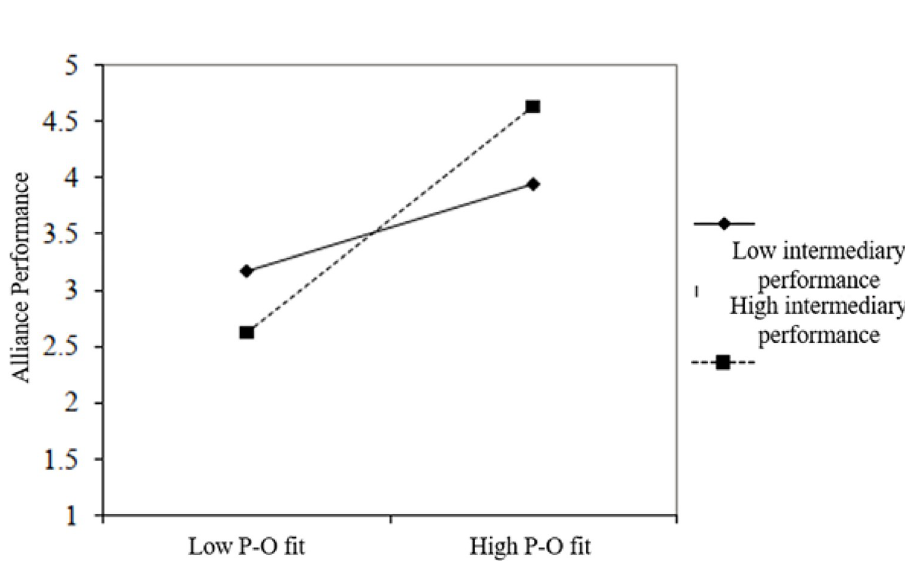
Fig 6. The relationship of intermediary performance to person-organization fit and alliance